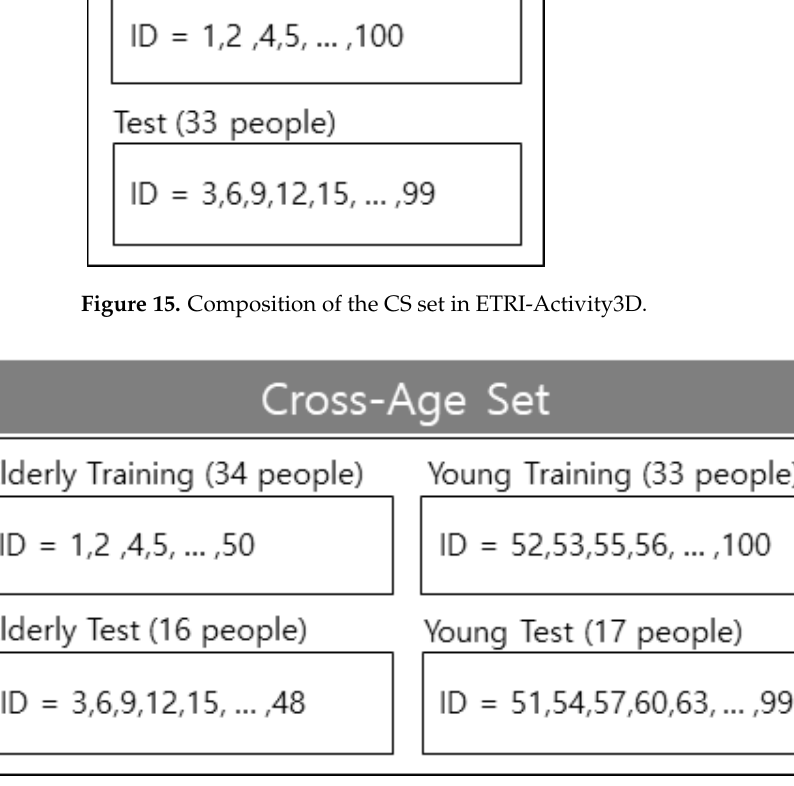
Figure 16. Composition of the CA set in ETRI-Activity3D.